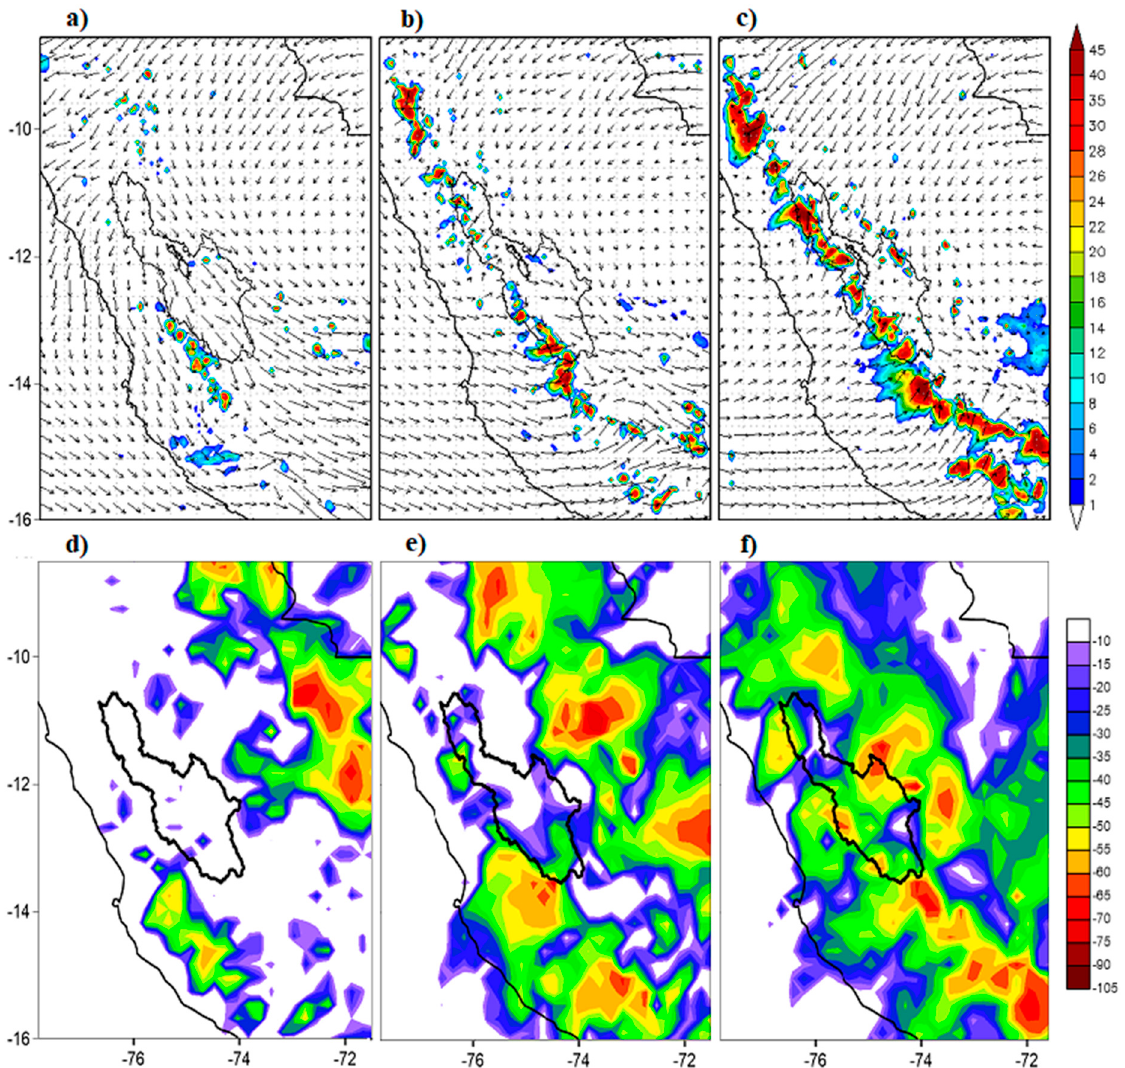
Figure 17. WRF-simulated maximum reflectivity (dBZ) and wind vector in 550 hPa (top); and corresponding GOES brightness temperature (°C) (bottom) over the region at 13 LST ( a , d ), 16 LST ( b , e ), and 19 LST ( c , f ) of 2 February 2011.